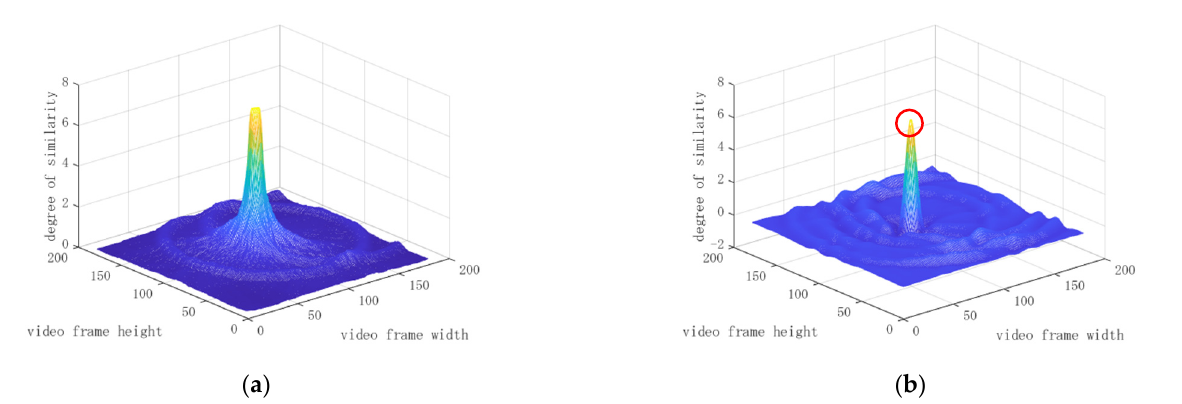
tqryxh : ( a ) Conventional Hough trans- 00